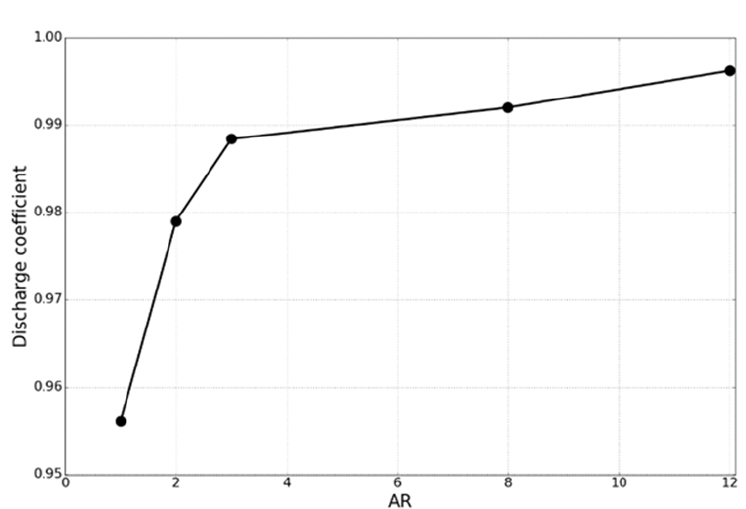
Figure 5 . AR vs. discharge coefficient. Figure 5. AR vs. discharge